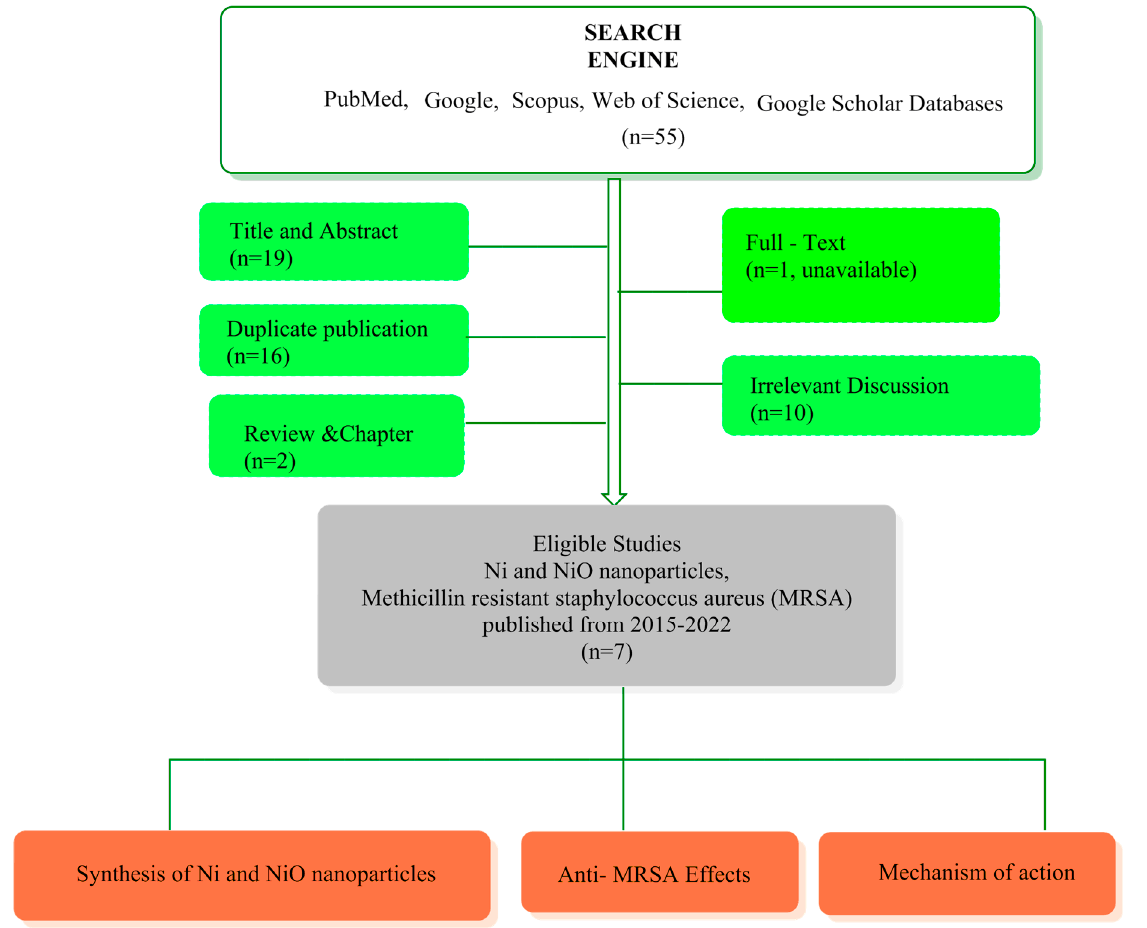
Figure 1. Flowchart of study procedure in this review.